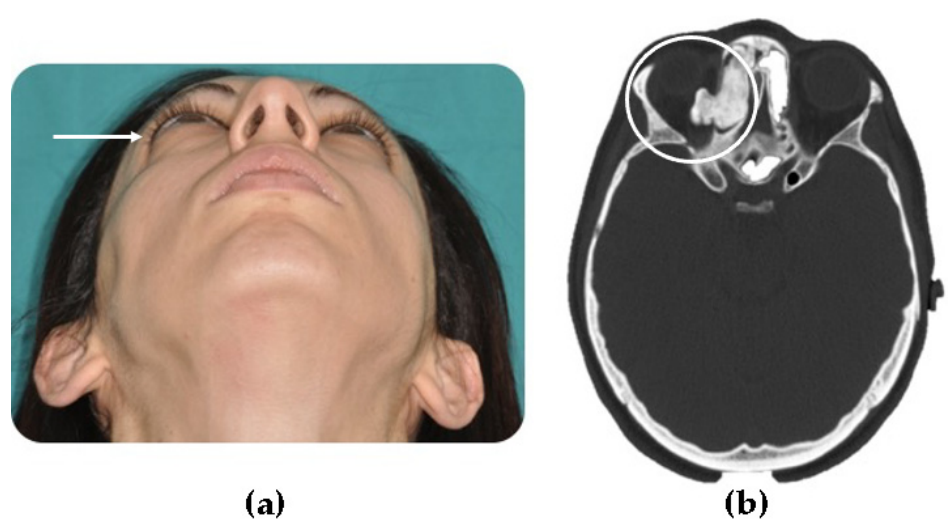
Figure 6. ( a ) A young patient presenting right exophthalmos (white arrow) due to an ethmoid osteoma with orbital invasion; ( b ) CT scan shows an extensive right ethmoid osteoma which invades the orbital cavity (circled in CT scan). Table 1. Literature review of the cases of solitary craniofacial osteomas reported from January 2020 to September 2021, with descriptions of clinical and diagnostic features. (F) female; (M) male; (CT) com-